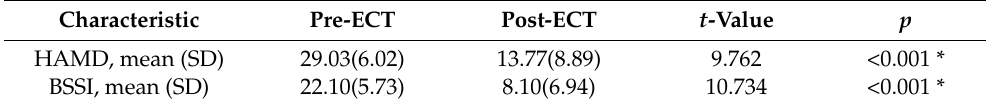
Table 3. Comparison of HAMD/BSSI scores pre/post-ECT.